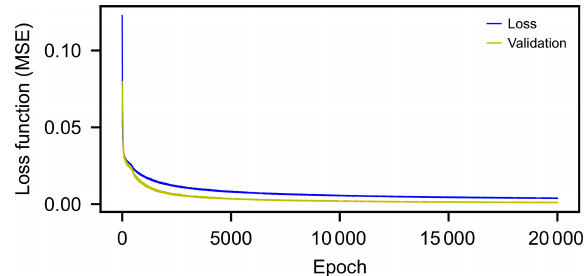
Figure 6. Training history of the NN; 3500 datasets and a 10km long sampling window were used for this training.